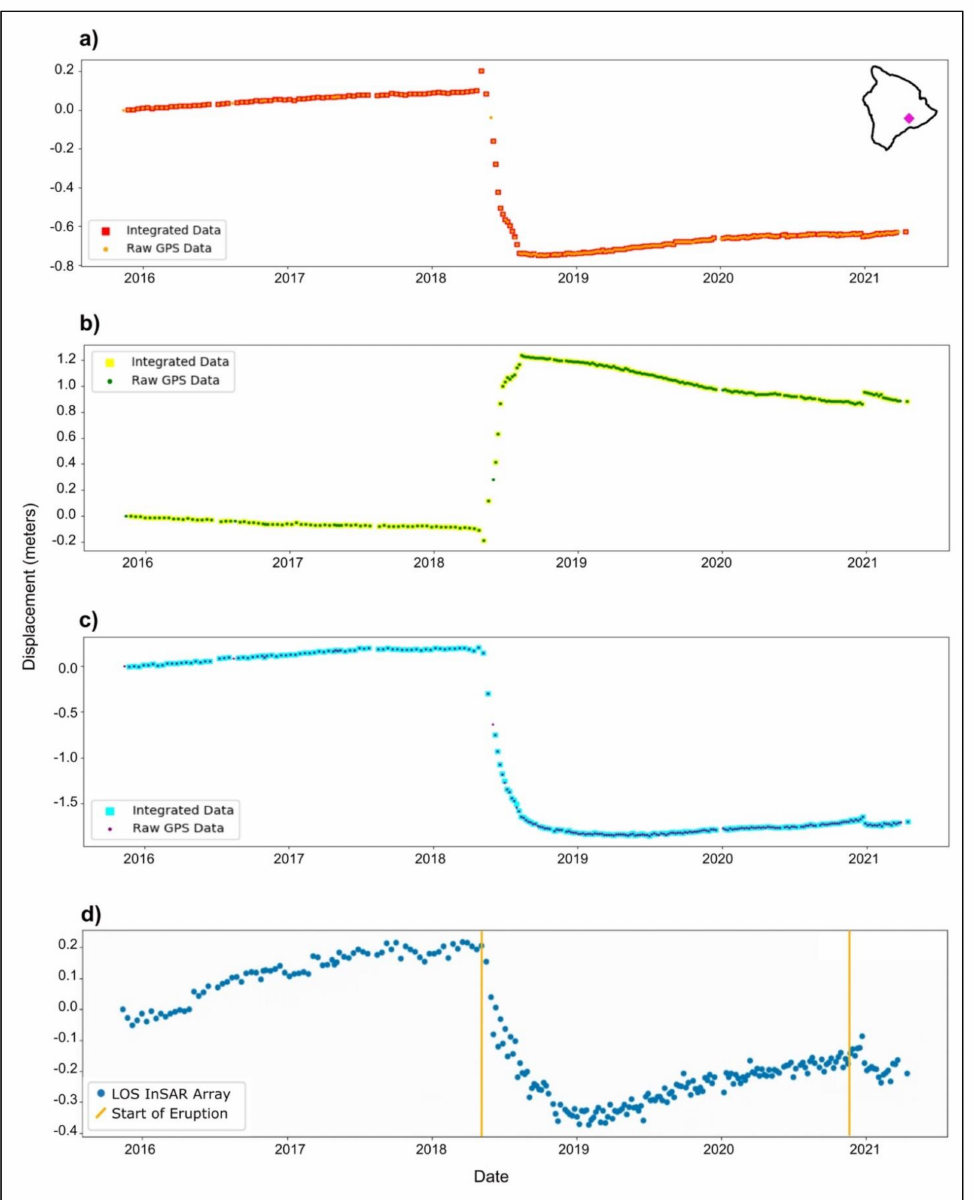
Figure 8. Integrated results compared to original, raw GNSS time series in the ( a ) east-, ( b ) north-, and ( c ) up-components of motion at the CRIM GNSS station (19.395 ◦ N, –155.274 ◦ W). ( d ) DInSAR LOS time series at the same pixel, over CRIM station. Yellow vertical lines indicate the May 2018 and December 2020 volcanic eruptions. The inset in subfigure a shows location of CRIM station in